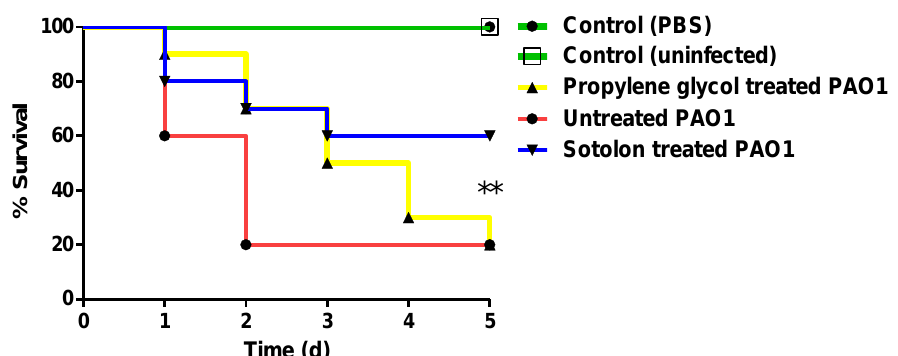
Figure 5. Sotolon in-vivo protection from P. aeruginosa . Five groups composed of 10 mice were used: two negative control groups either uninfected or injected with sterile PBS, 2 positive control groups were injected with propylene glycol treated PAO1 or untreated PAO1, and the last group were injected with sotolon in sub-MIC treated PAO1. Mice survival was observed, plotted using the Kaplan–Meier method, and significance ( p < 0.05) was calculated using a Log-rank test, GraphPad Prism 8. While no deaths were observed in the two negative controls, only 20% of mice were survived in positive control groups. Sotolon conferred 50% protection, as 6 mice injected with sotolon treated PAO1 were survived (Log rank test for trend p = 0.0019). ** = p < 0.01.